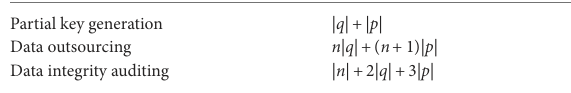
TABLE 2 Communication overhead. Phase Communication overhead Partial key